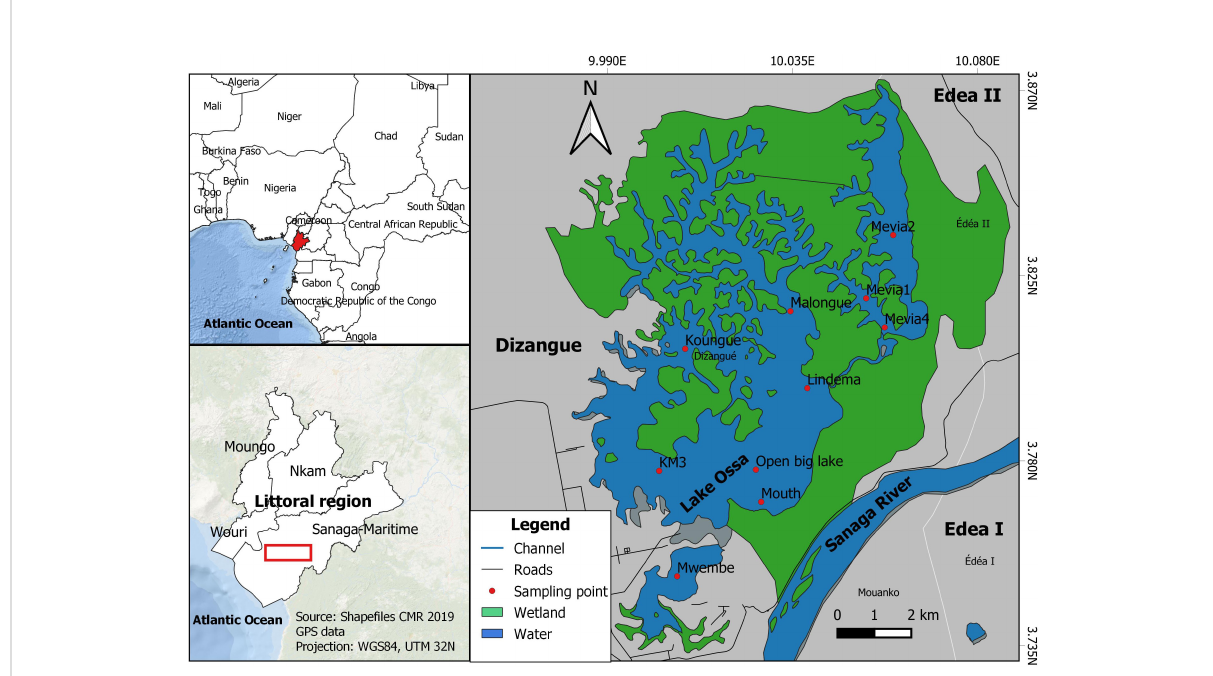
FIGURE 1 Map of Lake Ossa highlighting sampling sites with red circles. Koungue, Malongue, Mevia 1, Mevia 2 and Mevia 4 are sites situated in the salvinia-invaded area of the lake, whereas the other sites are in the uninvaded